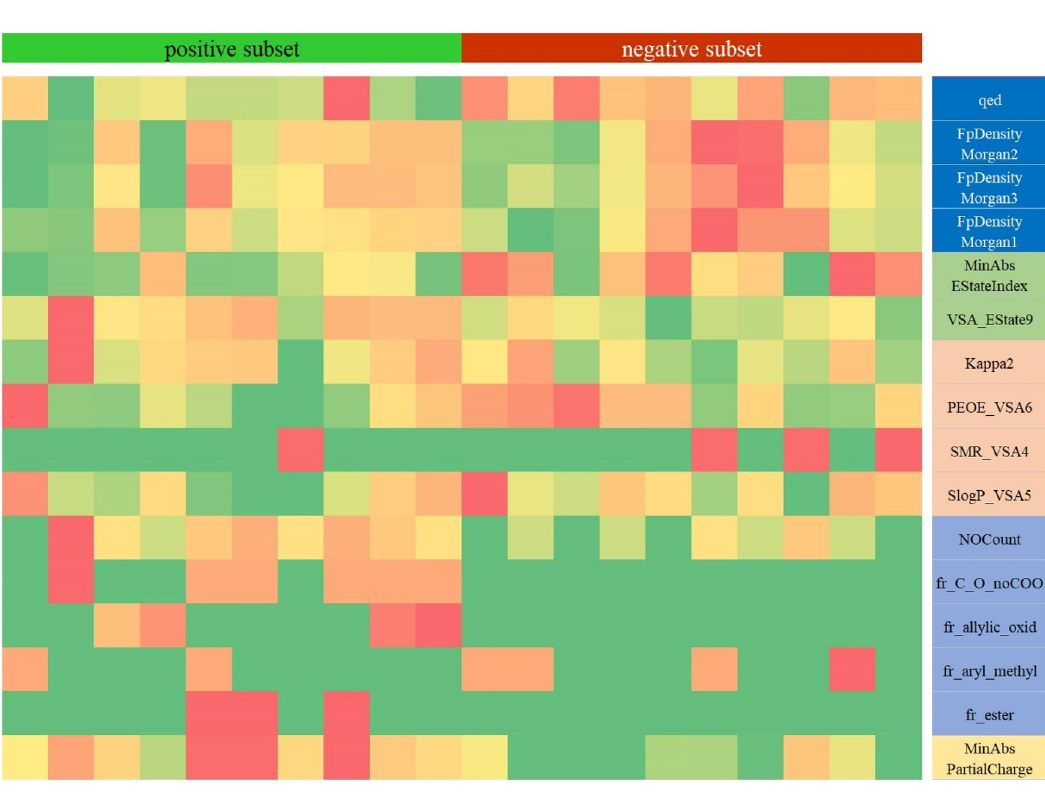
Figure 2. Heat map of the molecular descriptors